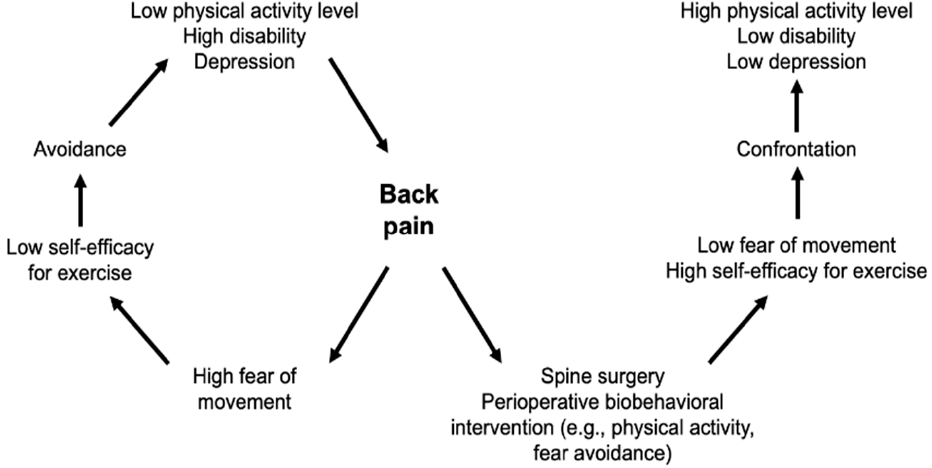
Figure 1. Modified fear–avoidance model for spine surgery Figure 1. Modi fi ed fear–avoidance model for spine surgery patients.